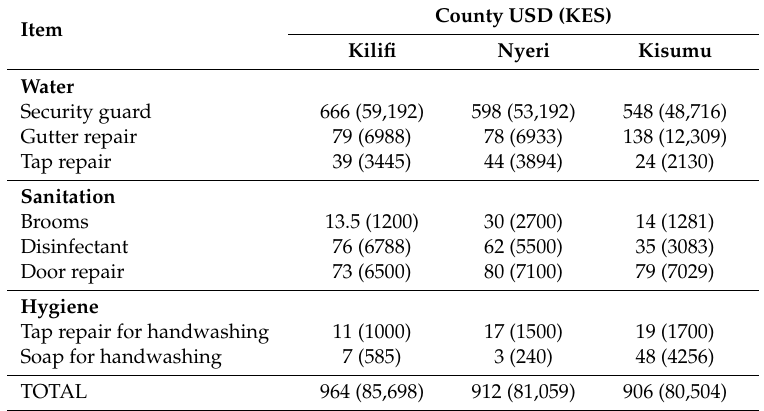
Table 3. Average expenditures of schools for select items per WASH domain, by county, Kenya